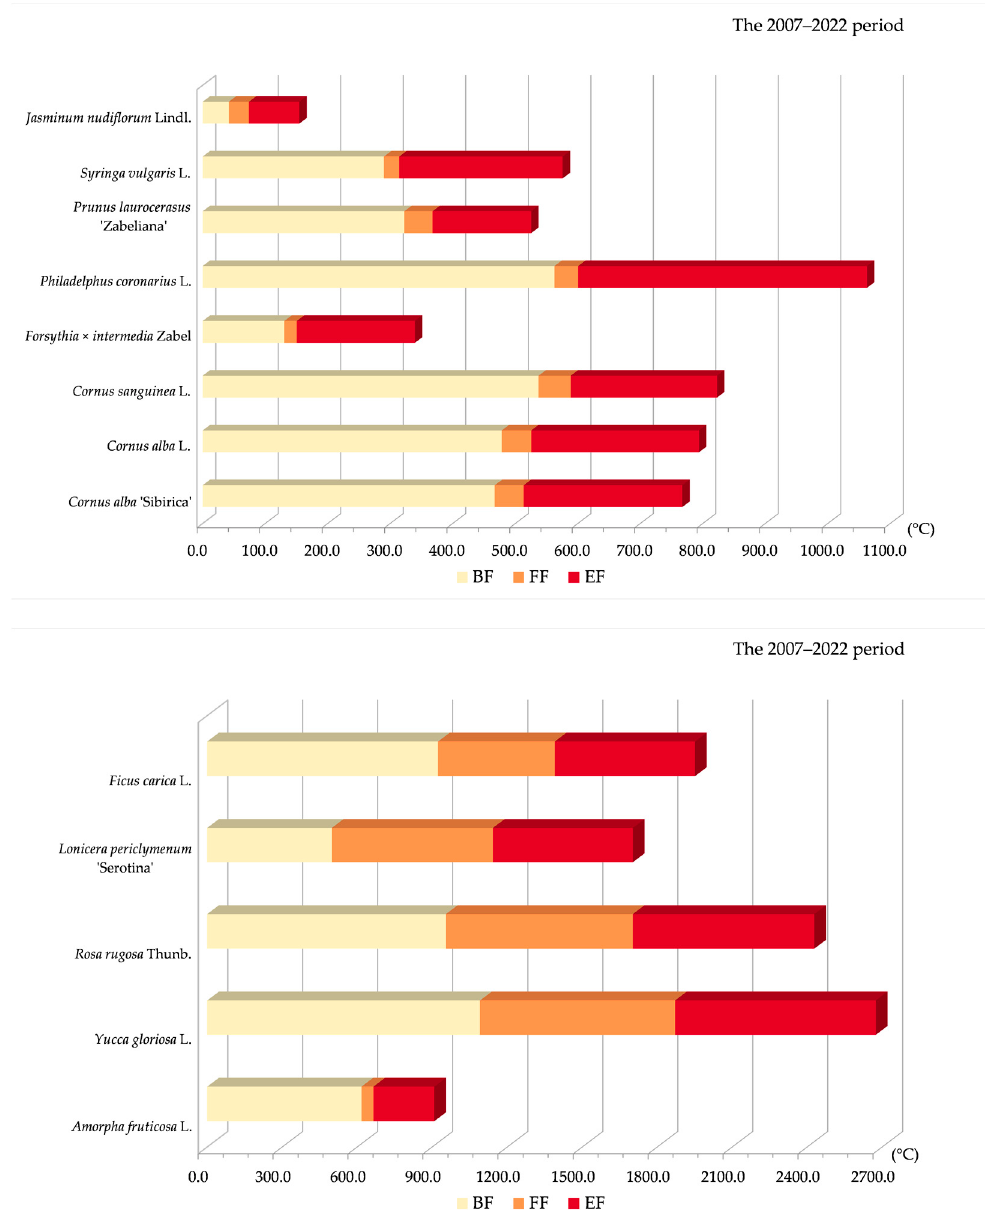
Figure 1. Phenological observations: periods and GDD (mean temperature sums) (°C) for the beginning of flowering (BF), full flowering (FF), and the end of flowering (EF) for 13 woody taxa based on data from the Belgrade (top) and Sur č in (bottom) stations for the period 2007–2022. The Mann—Kendall test determined linear trends (Figure 2, Table S6) for temperature sums (GDD) for each flowering phenophase for 13 taxa for 16 consecutive years. A positive value indicates an increasing trend and a negative value indicates a decreasing